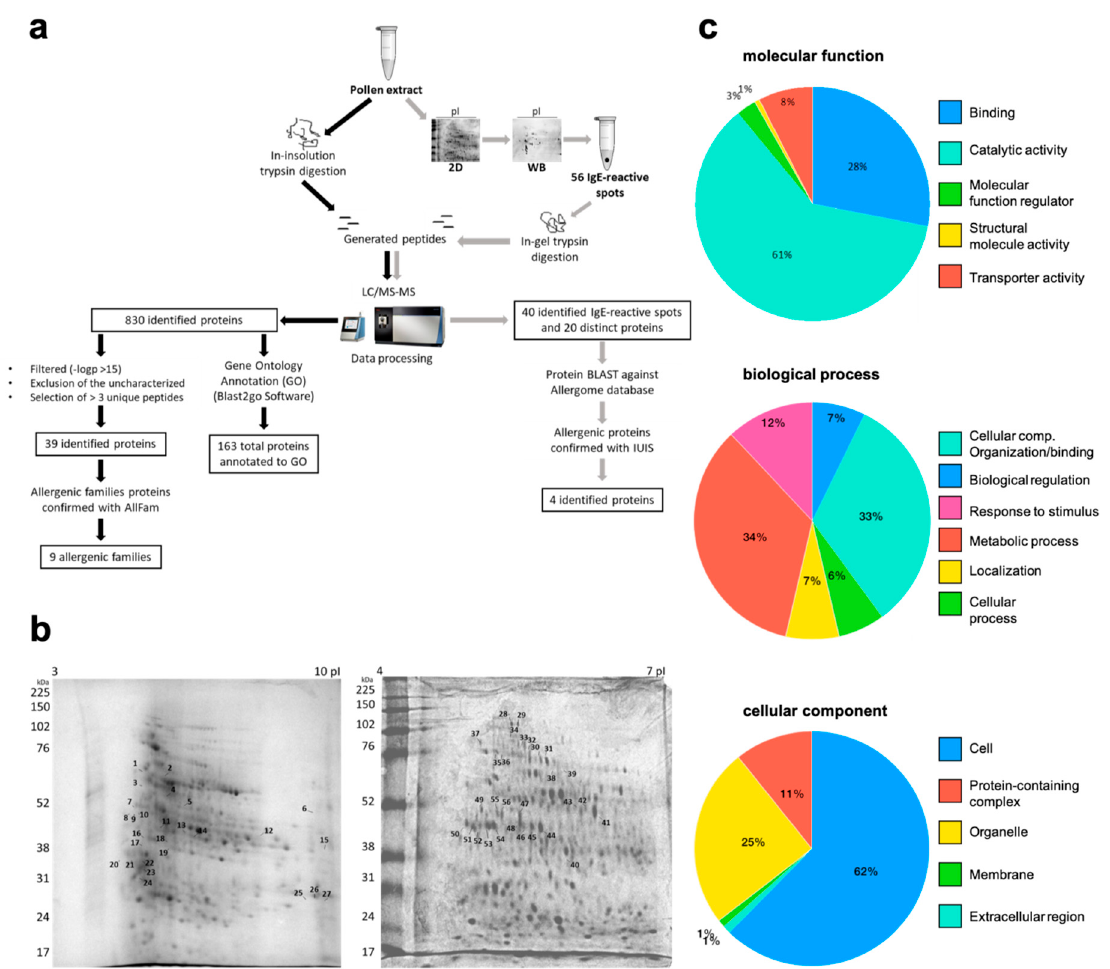
Figure 2. Proteomics of cashew tree pollen reveals the presence of allergenic protein families and IgE-reactive molecules. ( a ) Summarized workflow and results of the proteomic analyses. ( b ) 2D-SDS-PAGE (isoelectric point (pI) 3–10 and 4–7) stained by Coomassie. All excised spots subjected to mass analysis are numbered (1–27 and 28–56). ( c ) Gene ontology annotation of identified proteins from cashew tree pollen using PantherDB. A total of 163 proteins were annotated to a biological process, cellular component, and molecular function.